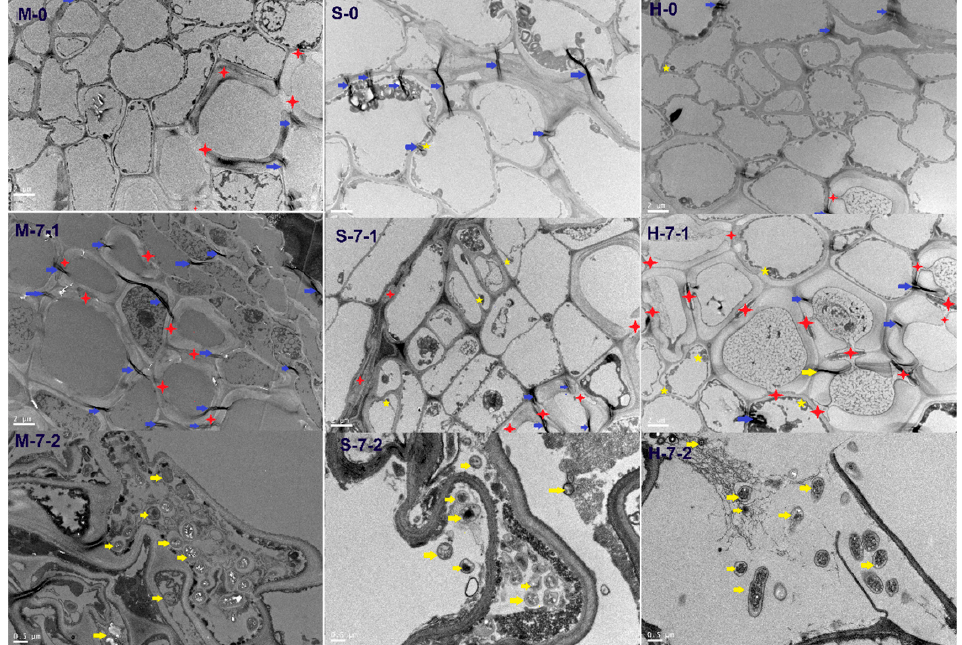
Figure 12. Comparison of ultra-structure of fine roots of different peach rootstocks exposed to 7 d of waterlogging stress under TEM (red and yellow asterisk: mycorrhizal fungi infection; blue arrow: mycelium; yellow arrow: bacteria, actinomycetes or fungal spores; bar = 0.5 μ m (M-0, S-0, H-0); bar = 2 μ m (M-7-1 and M-7-2, S-7-1 and S-7-2, H-7-1 and H-7-2)). Abbreviations: M: Prunus persica, ‘Maotao’; S: Prunus davidiana, ‘Shantao’; H: ‘Hossu’. Leaf samples were collected under un-stressed